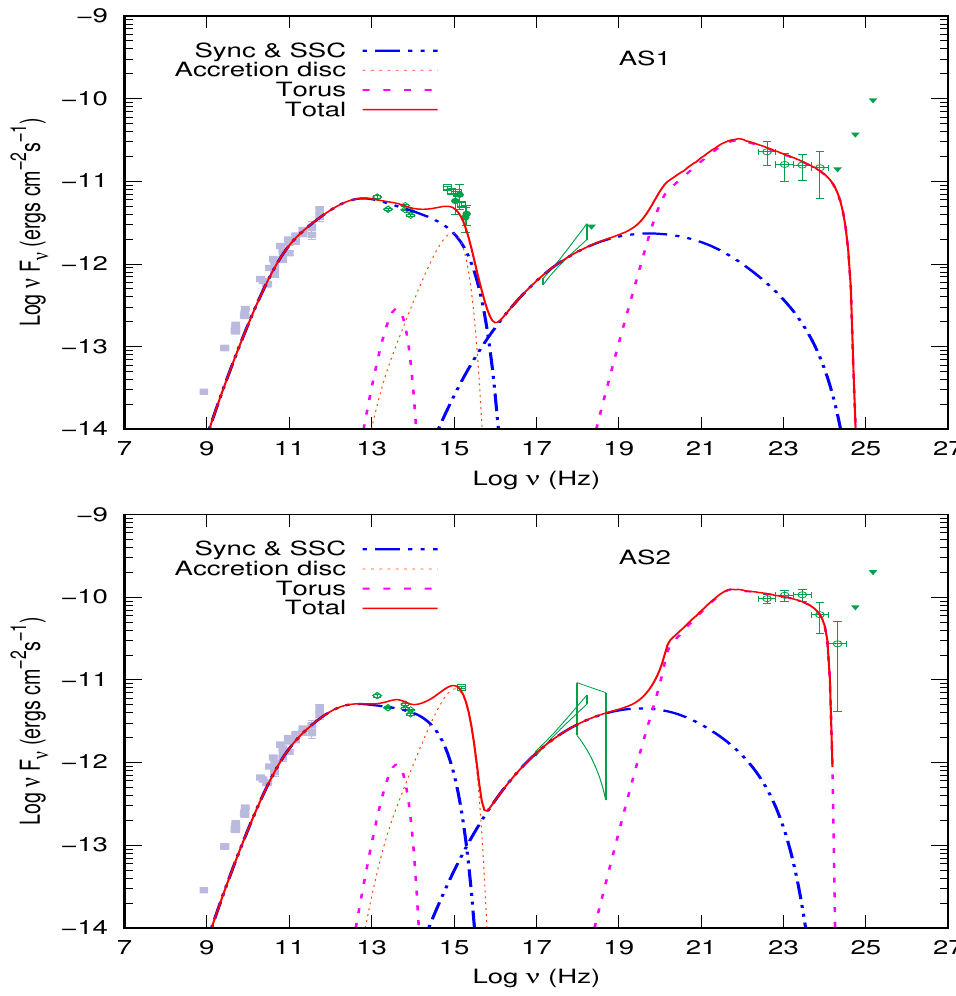
Figure 3. Broad-band SED of PKS 0208 − 512 during AS1 and AS2. Open circle: Fermi -LAT, unfilled butterfly: AstroSat SXT and LAXPC, open square: Swift -UVOT, unfilled upper-triangle: SMARTS , open diamond: WISE , filled square: archival radio data taken from ASDC SED Builder [93] and downward triangle: upper limit value. The different lines represent the contribution of individual emission component. The solid line represents the total (Sync+SSC+accretion disk + BLR and dusty torus) SED model